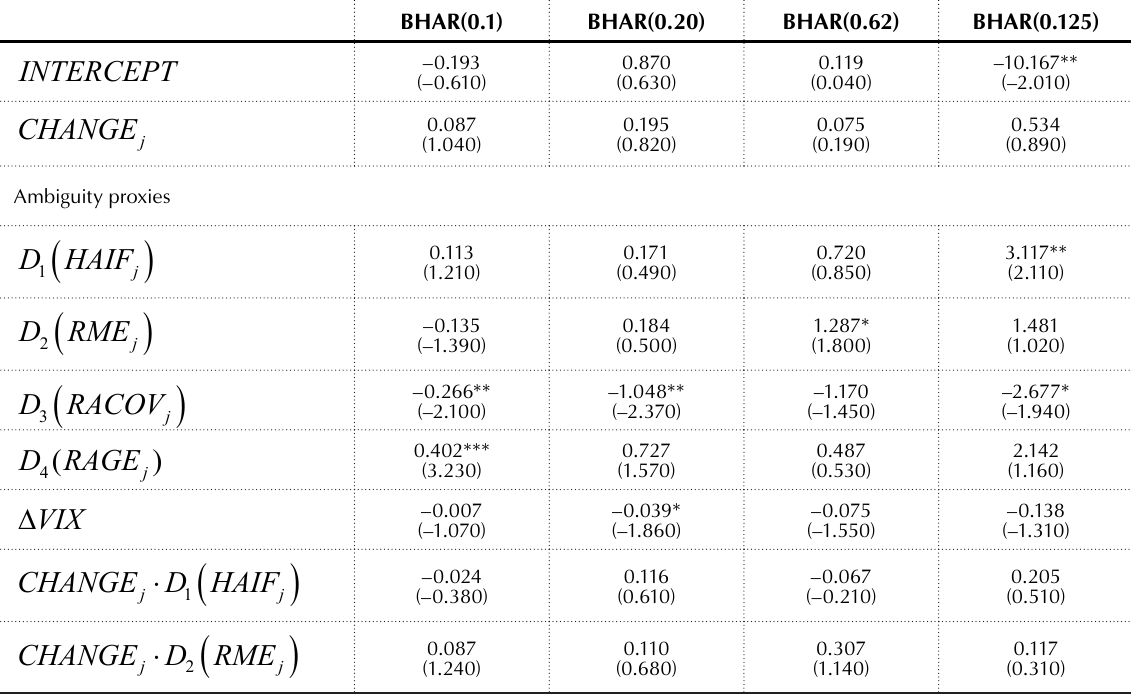
Table 5. Ambiguity and BHARs: controlling for both ambiguity and characteristics